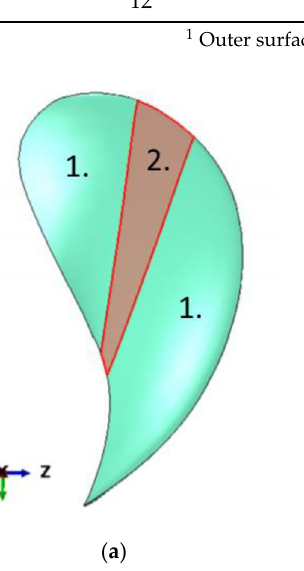
Figure 2. The investigated fibre-reinforced polymer (FRP) material layup design. The stacking arrangement of the plies in the layup is given in Table 1. ( a ) Suction side of the design; ( b ) pressure side of the design. Table 1. Layup of the design in Figure 2. The colours indicate the different CFRP plies. The red colour is for backing plies, black is for UD plies, and green is for surface plies. The 0° orientation is in the green Y direction in Figure 2. Regions in Figure 2